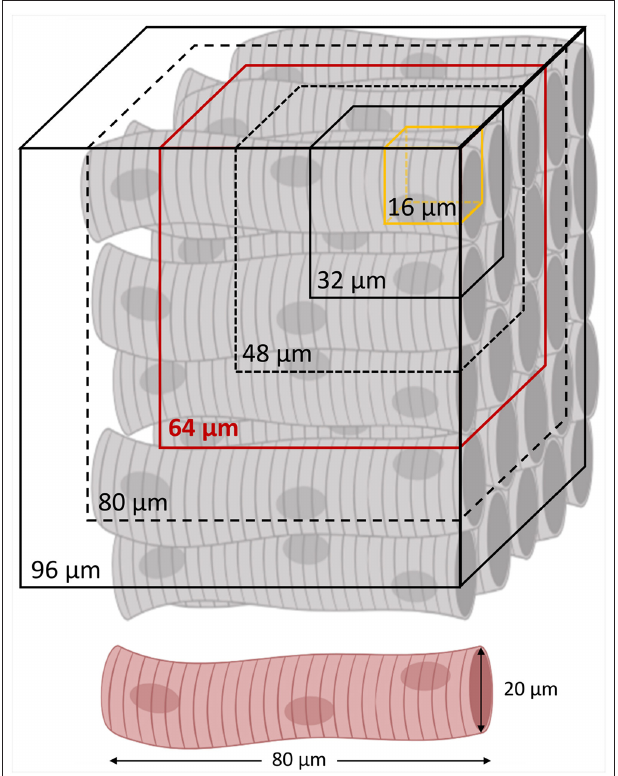
FIGURE 3 | Spatial resolutions of local disarray quantification. A regular cardiomyocyte architecture is schematized with the different spatial resolutions involved in the local disarray quantification. The minimum (a 32 µ m side cube) and the maximum (a 96 µ m side cube) macrovoxel include, respectively, 2 2 2 and 6 6 6 orientation vectors evaluated in a sub-volume of × × × × 16 µ m sides (in yellow). In red is highlighted the average spatial resolution of 64 µ m, selected to create the 3D maps of the local disarray, and for the myocyte angular dispersion estimation by virtual sample